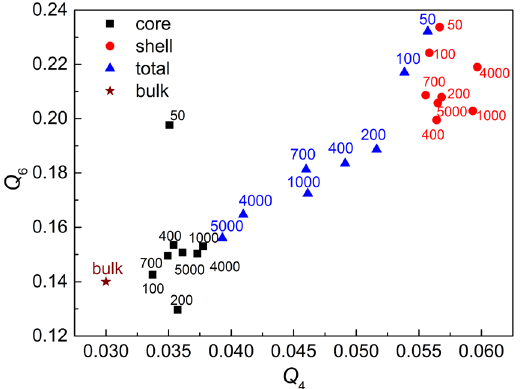
Figure 5. The Q 6 - Q 4 distribution of Cu 64 Zr 36 SSAPs (total, core and shell components) with various sizes together with the bulk sample. Numbers of atoms are marked.